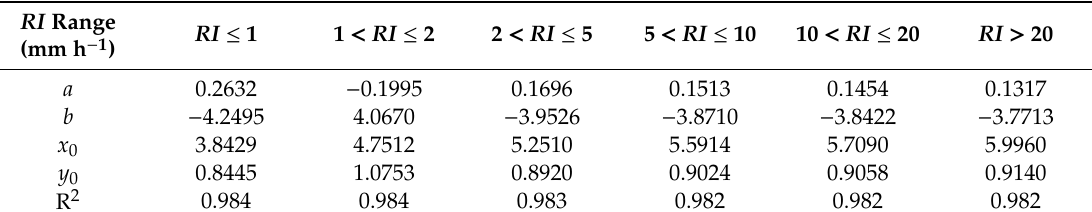
Figure 5. Raw CE values (diamonds) obtained by using the parameters derived from the MP exponential interpolation function, for each RI class, and the associated sigmoidal functions (dash-dot lines). Table 3. Parameters of the sigmoidal functions obtained by fitting the raw CE values derived by using the MP parameters from the exponential interpolations and correlation factors for each RI class.